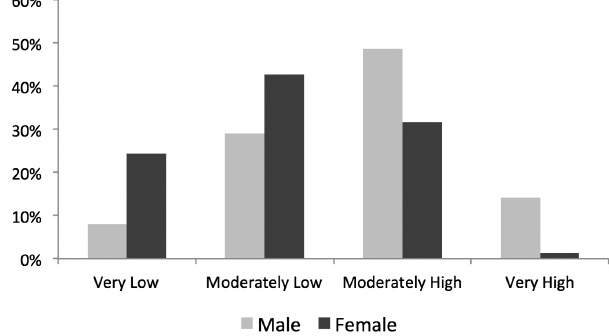
FIG. 5. Distribution of self-efficacy state experiences in IE physics by